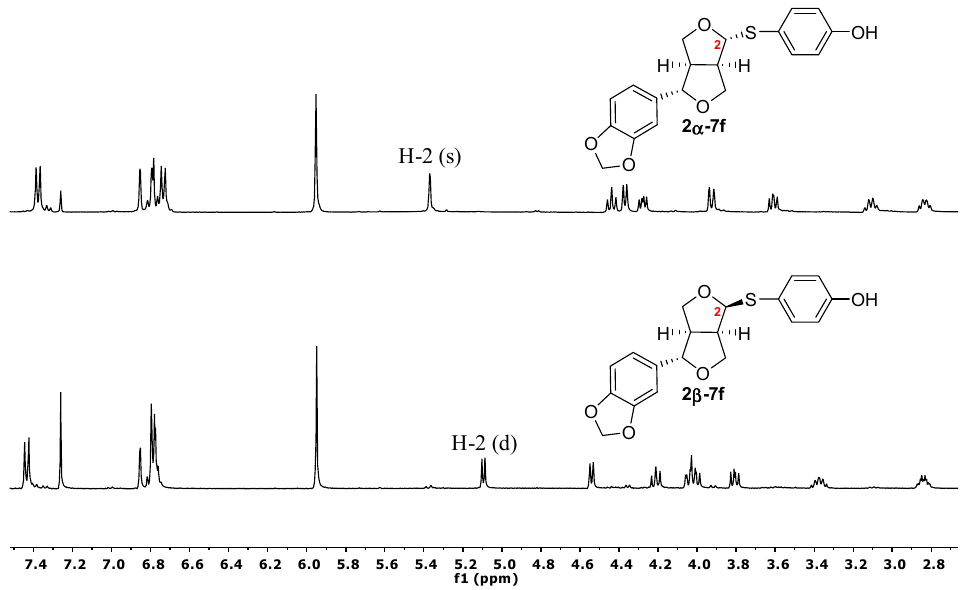
Figure 2. 1 H NMR spectra of 2 α -7f ( top ) and 2 β -7f ( bottom ).